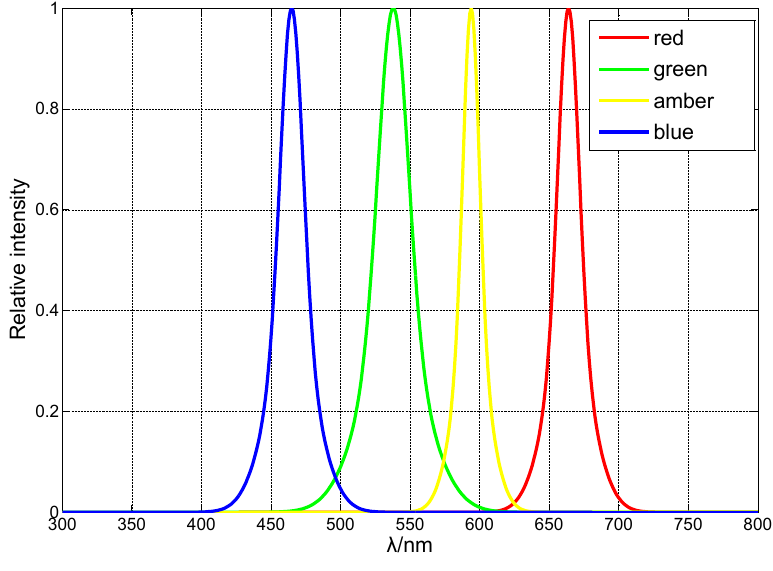
Figure 2. Emission spectra of LEDs with different